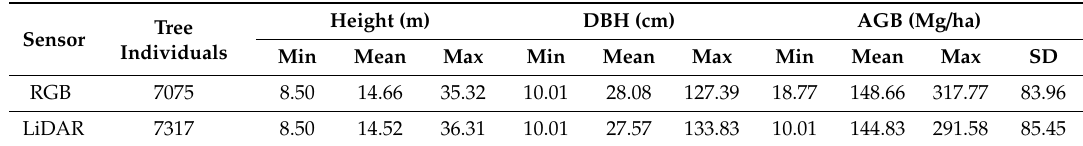
Table 2. Calculated H, DBH, and AGB values (RGB above and LiDAR below).